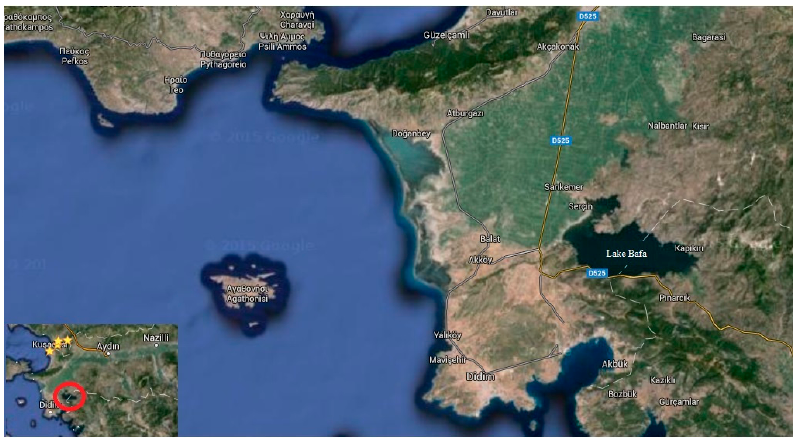
Figure 1. General view of Lake Bafa [7].